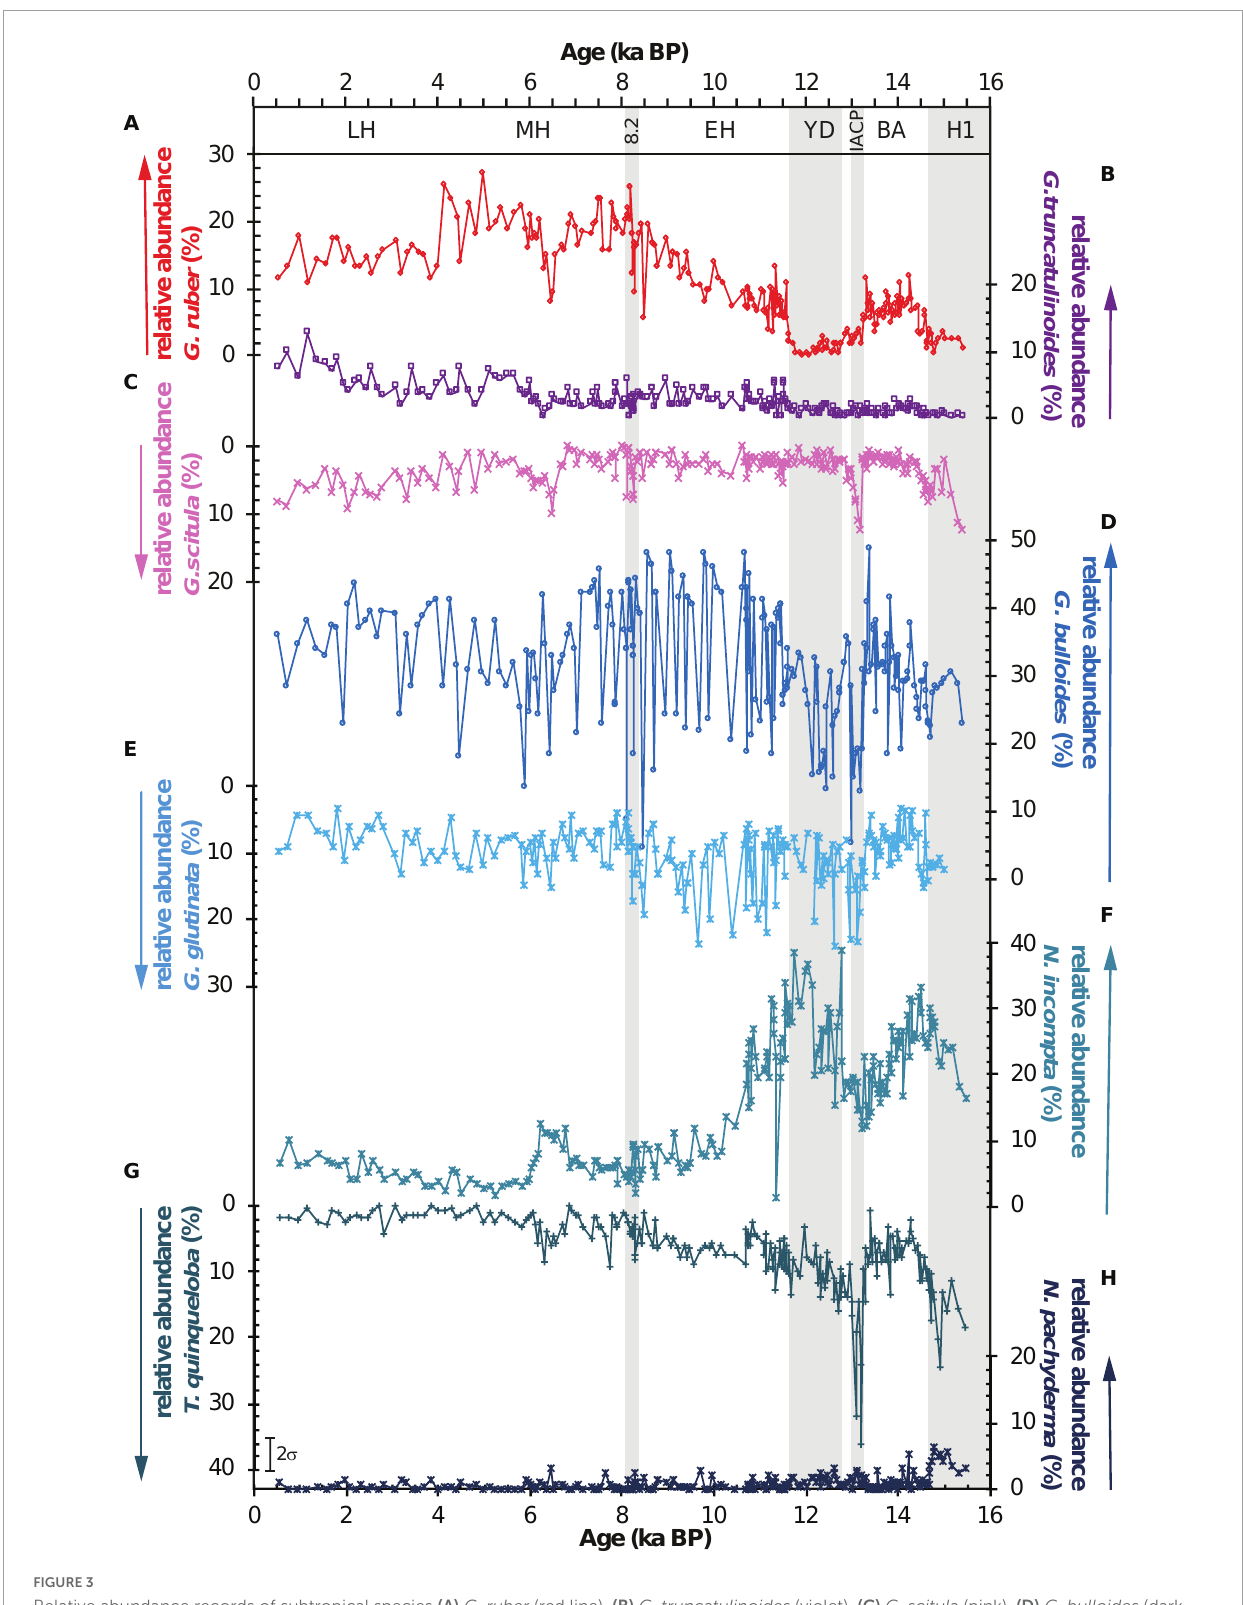
FIGURE3 Relative abundance records of subtropical species (A) G. ruber (red line), (B) G. truncatulinoides (violet), (C) G. scitula (pink), (D) G. bulloides (dark blue), (E) G. glutinata (light blue), (F) N. incompta (light green-blue), and sub/polar species (G) T. quinqueloba (dark green-blue), and (H) N. pachyderma (dark blue). Note that the y -axes of the temperate and subpolar species G. scitula , T. quinqueloba , N. incompta , and N. pachyderma are inversely plotted. For abbreviations on time axis see Figure 2